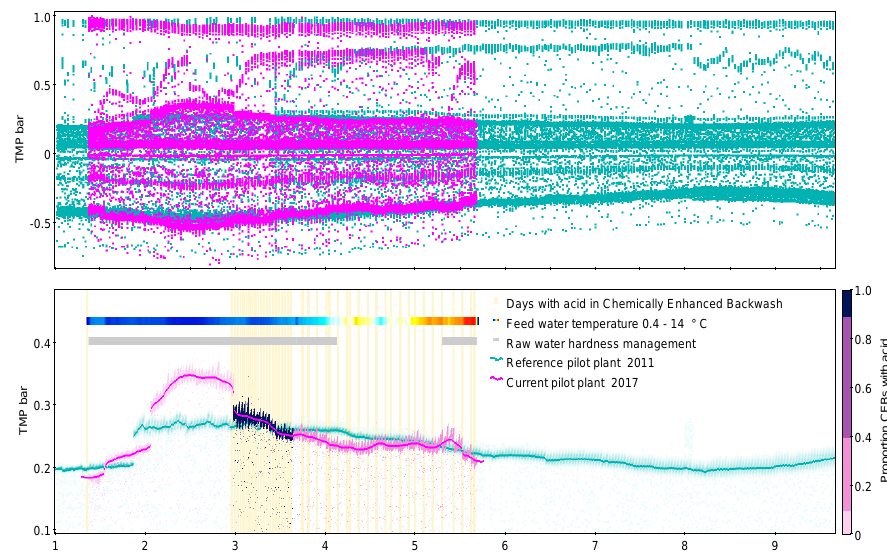
Figure 10. Time series (decimal month January–September) of Trans Membrane Pressure over two different ultrafiltration pilot plants in Gothenburg Sweden (7.7M rows). ( Top ) Two series of correct but noisy raw data, obviously not suitable for mean aggregations; ( Bottom ) Exactly the same data as top display, clarified by use of subsets, transparency, quantile smoothers, marking by auxiliary Y axis, histogram by time as event marking, and densograms for additional quantitative variable as well as operational information. Credit: H. Rydberg, Sustainable Waste and Water, City of